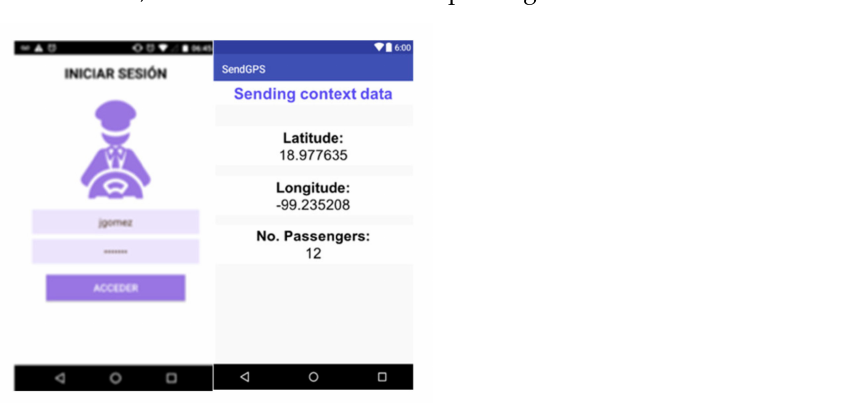
Figure 15. The login Interface for the bus driver and the interface for bus location and passengers.